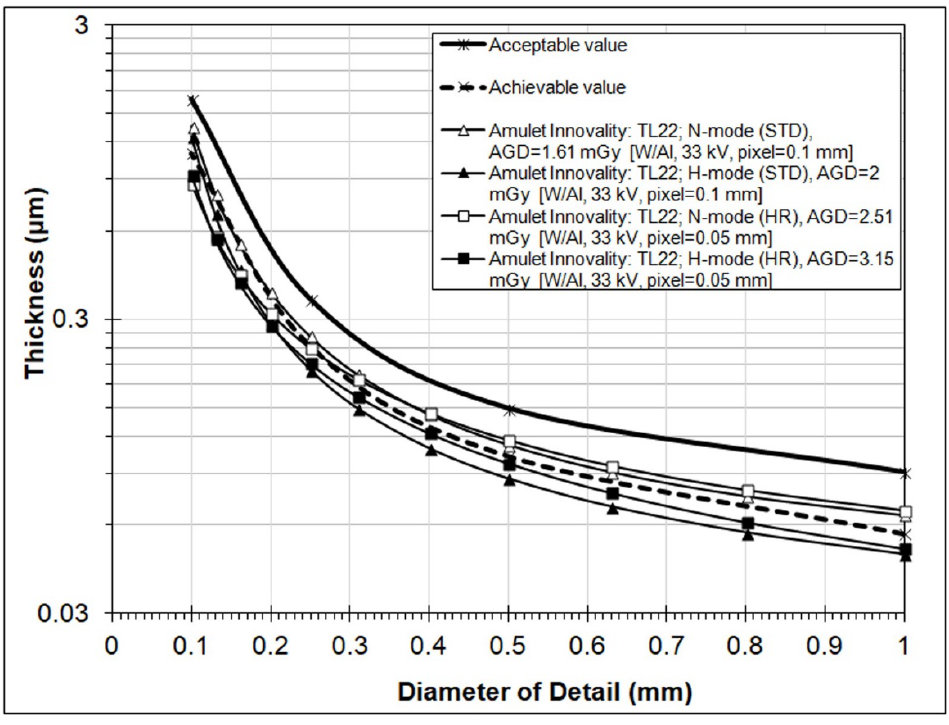
Figure 5. Contrast–detail curves for tomographic images (TL22) obtained using four different oper- ation modes (N-mode (ST), H-mode (ST), N-mode (HR), and H-mode (HR)) for DBT acquisitions. The curve for H-mode (HR) is based on a single image. (Results from the CDMAM3.4 Analyser software.)